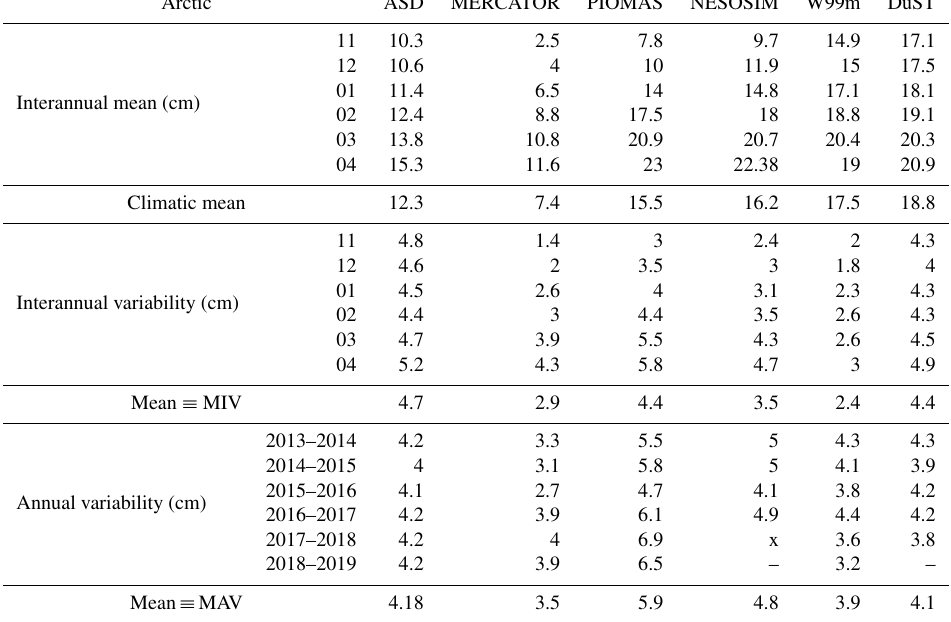
Table A1. Statistical comparison of the different snow depth estimations in the Arctic over the 6 winters of the 2013–2019 period. AMSR2’s data are not indicated since only the months of March and April were available.